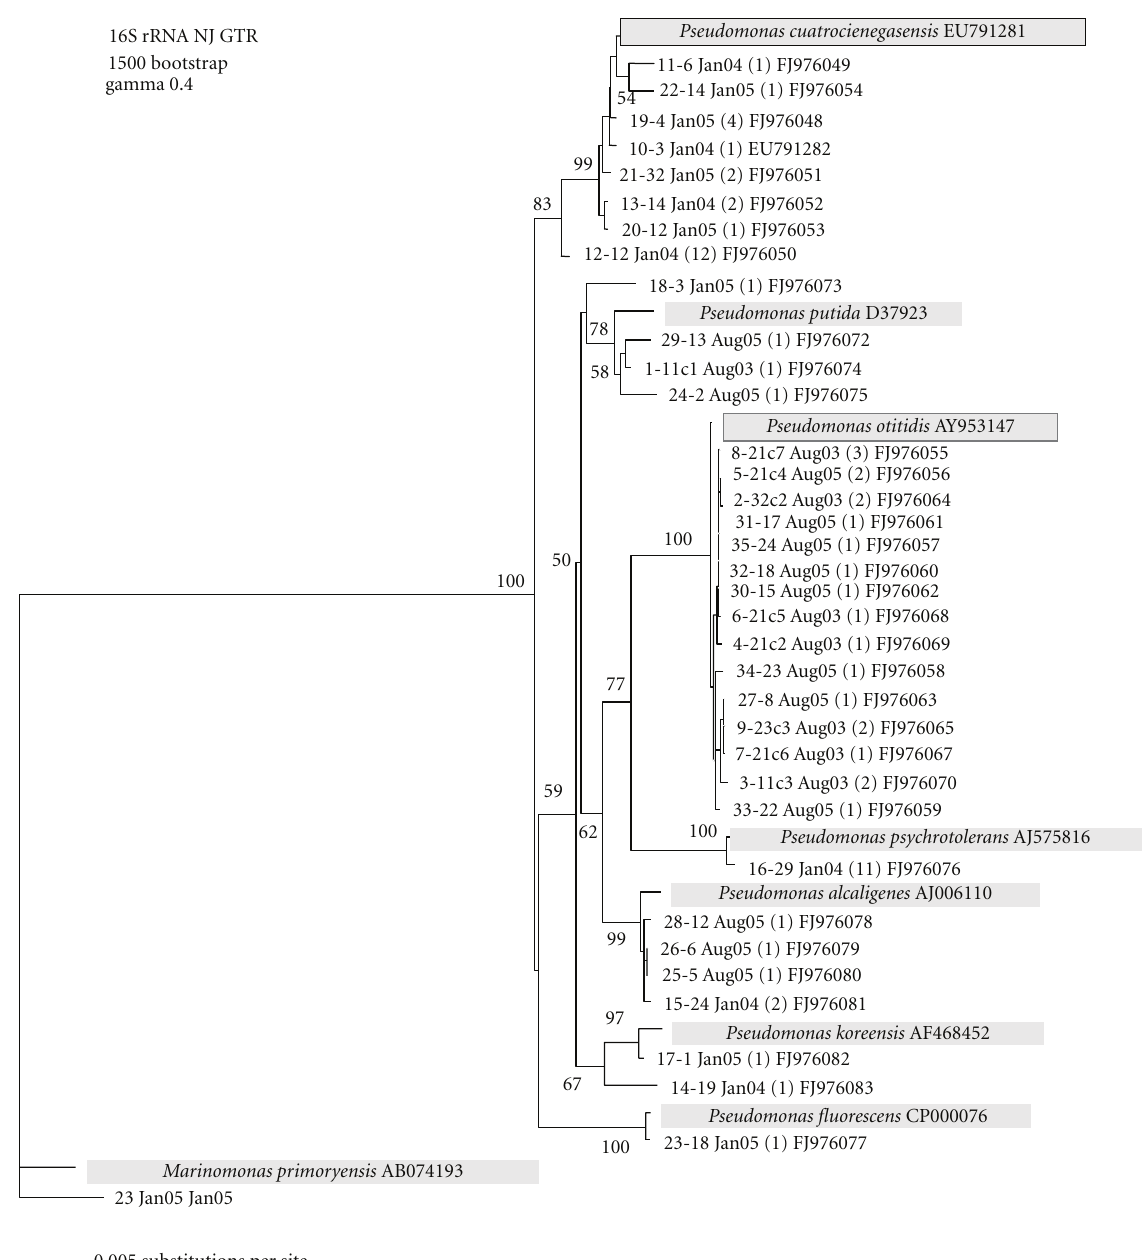
Figure 3: Neighbor-joining tree (GTR, gamma correction 0.40) of 16S rDNA sequences. Sequences are from Pseudomonas isolates from Laguna Grande water samples taken in August 2003, January 2004, January 2005, and August 2005. The number of strains having identical fingerprint pattern is in parentheses. The numbers at the nodes are bootstrap values based on 1500